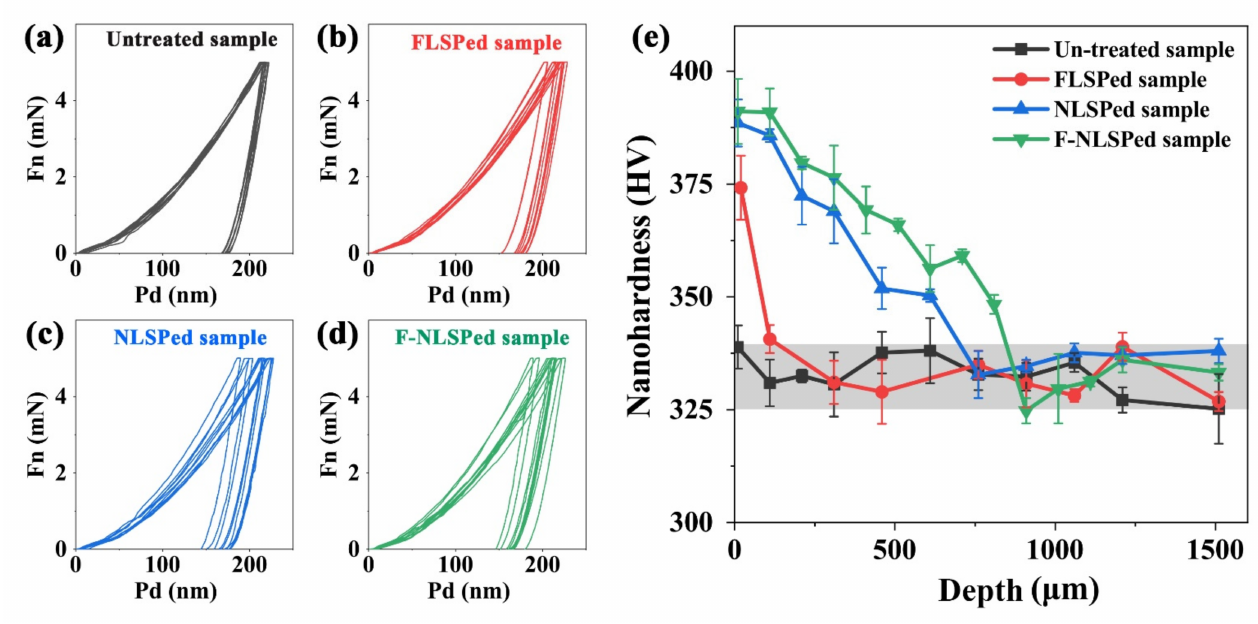
Figure 4. Nanoindentation analyses of un-treated and LSPed surfaces. The Fn–Pd curve of ( a ) un- treated, ( b ) FLSPed, ( c ) NLSPed, and ( d ) F-NLSPed samples; ( e ) Nanohardness of un-treated and LSPed